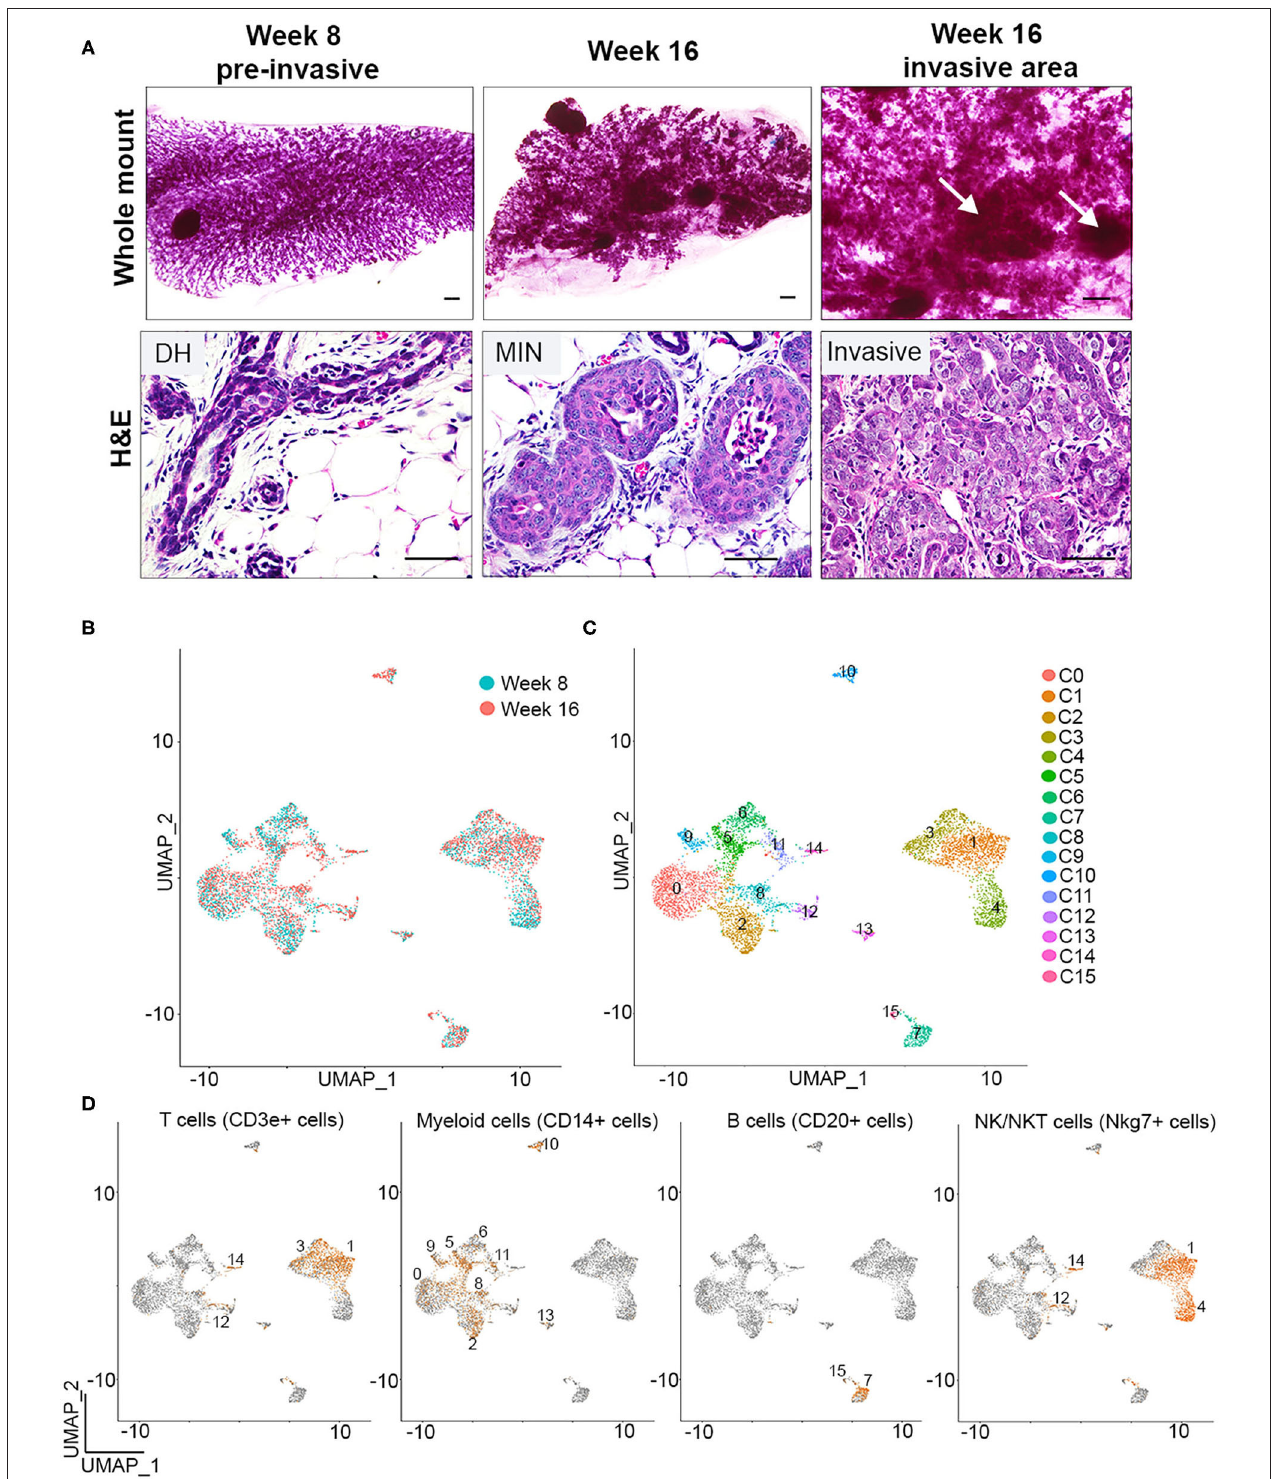
FIGURE 1 | Single cell identification of immune cells during early breast cancer progression. (A) Whole mounts (top) and H&E staining (bottom) depicts PN1a outgrowths with ductal hyperplasia (DH) at 8 weeks (left), MIN (middle) at 16 weeks, or invasive lesions (right) at 16 weeks post-transplantation ( n = 6). Arrows depict area of invasion. Scale bars = 200 µ m (top) or 50 µ m (bottom). (B) UMAP distribution of CD45 + cells isolated from PN1a lesions at 8 weeks (blue) or 16 weeks (red) post-transplantation. (C) UMAP of CD45 + cells as 16 distinct clusters. (D) Feature plots depicting Cd3e (T cells), Cd14 (myeloid cells) Cd20 (B cells) and Nkg7 (NK/NKT cells) mRNA